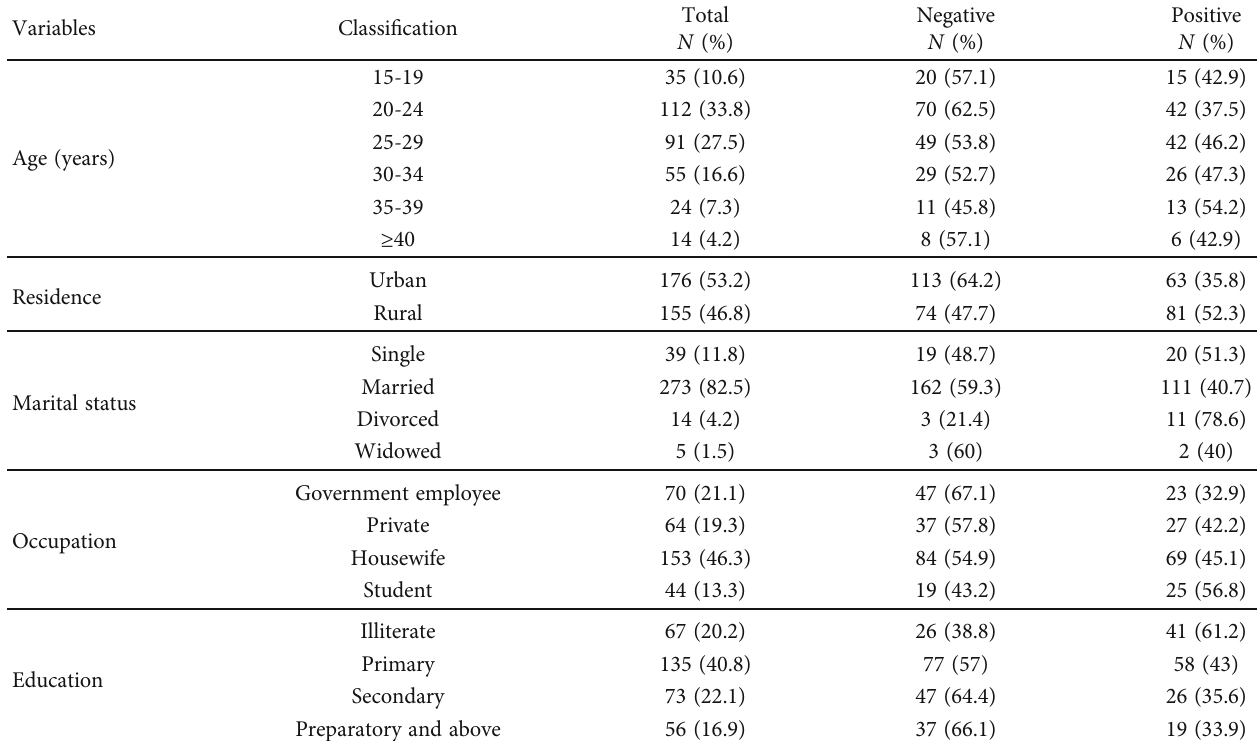
Table 1: Sociodemographic characteristics of pregnant women with respective to IPs in Woreilu Health Center, Woreilu, Northeast Ethiopia, from October 2018 to February 2019.